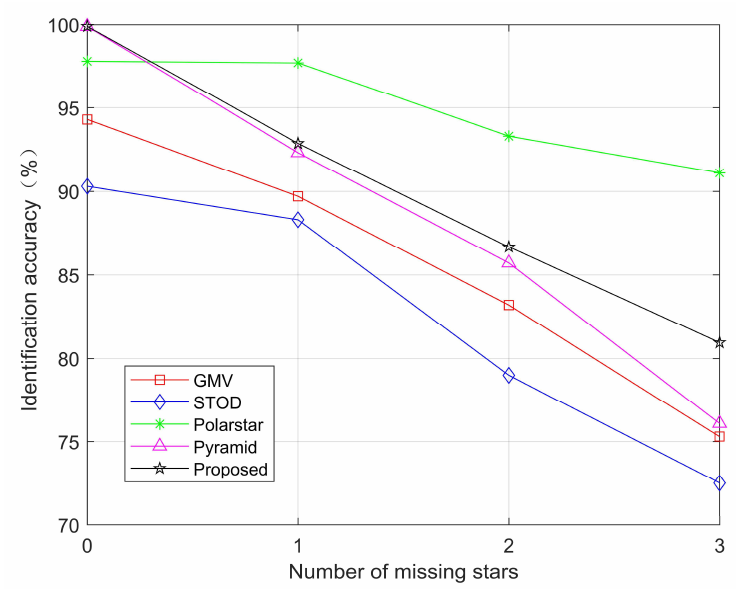
Figure 20. Identification accuracy benchmarking for sensitivity to missing stars.